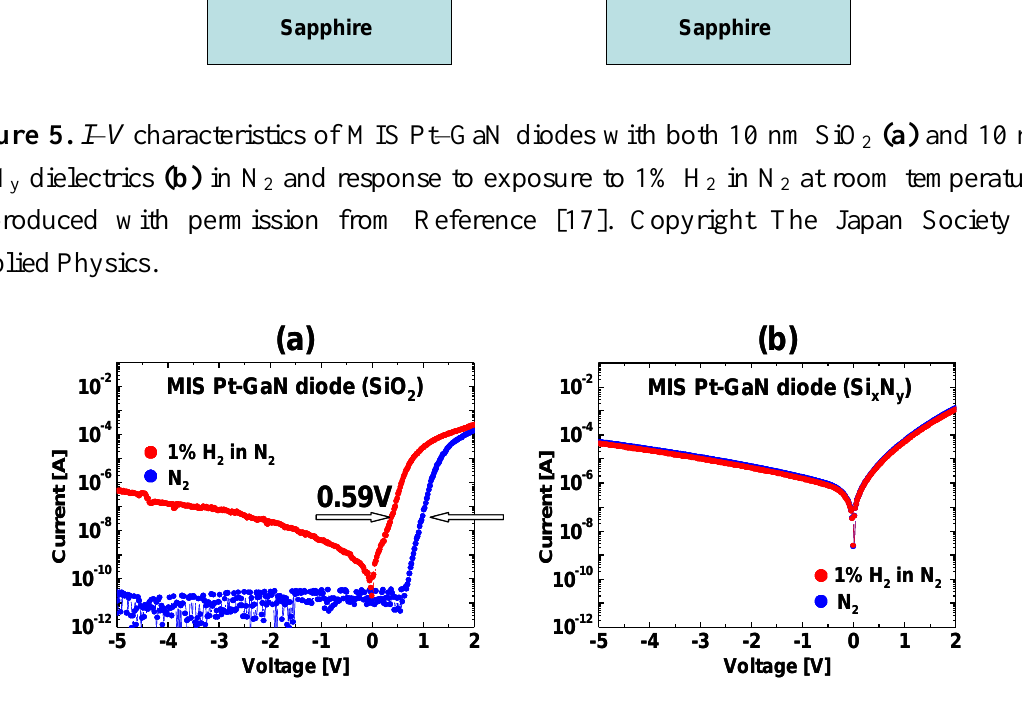
and response to exposure to 1% H 2